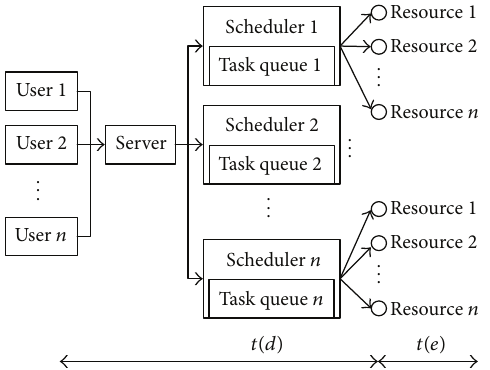
Figure 1: Scheduling model of user tasks in cloud